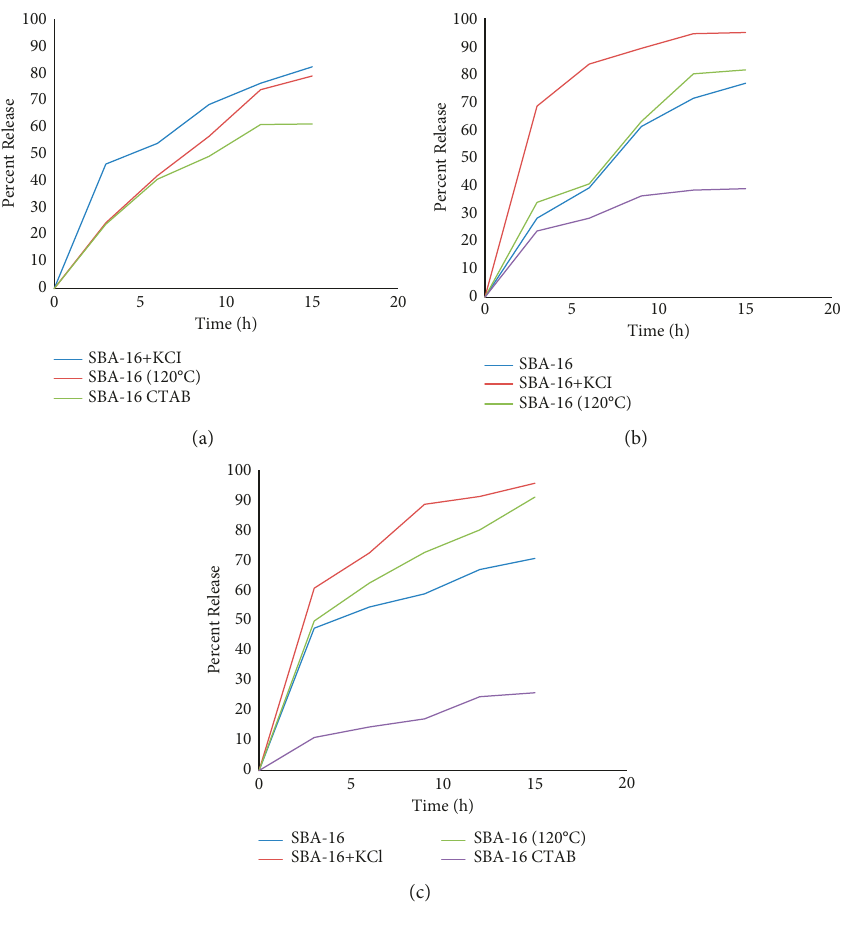
Figure 7: IBU release from different mesoporous silica samples. (a) Release of ibuprofen at 0.015 g. (b) Release of ibuprofen at 0.025g. (c) Release of ibuprofen at 0.035g.